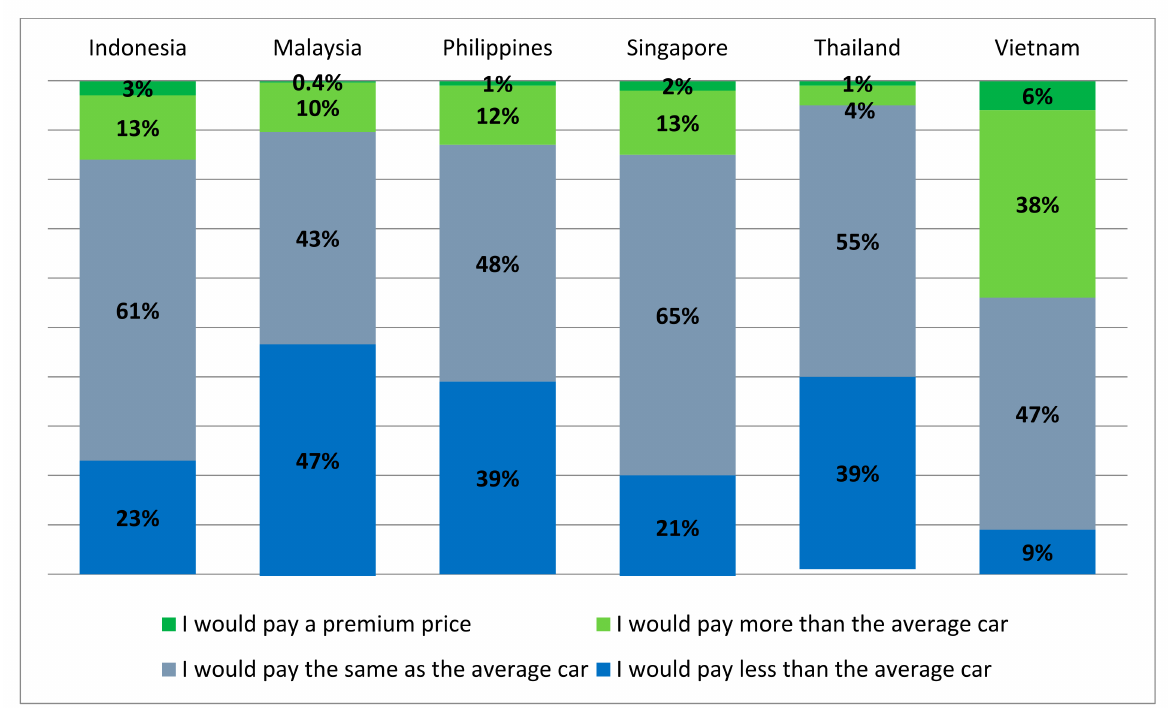
Figure 7. Consumers’ expected EV price range after incentives in selected ASEAN countries. Source: https://www2.deloitt e.com/content/dam/Deloitte/sg/Documents/strategy/sea-strategy-operations-full-speed-ahead-report.pdf (accessed on 4 November 2021)